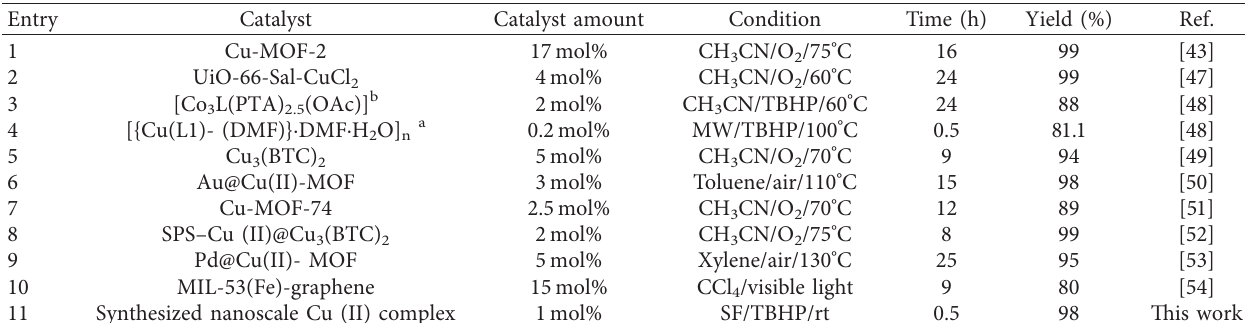
Table 2: Comparison of catalytic activity in alcohol oxidation reaction with previously reported